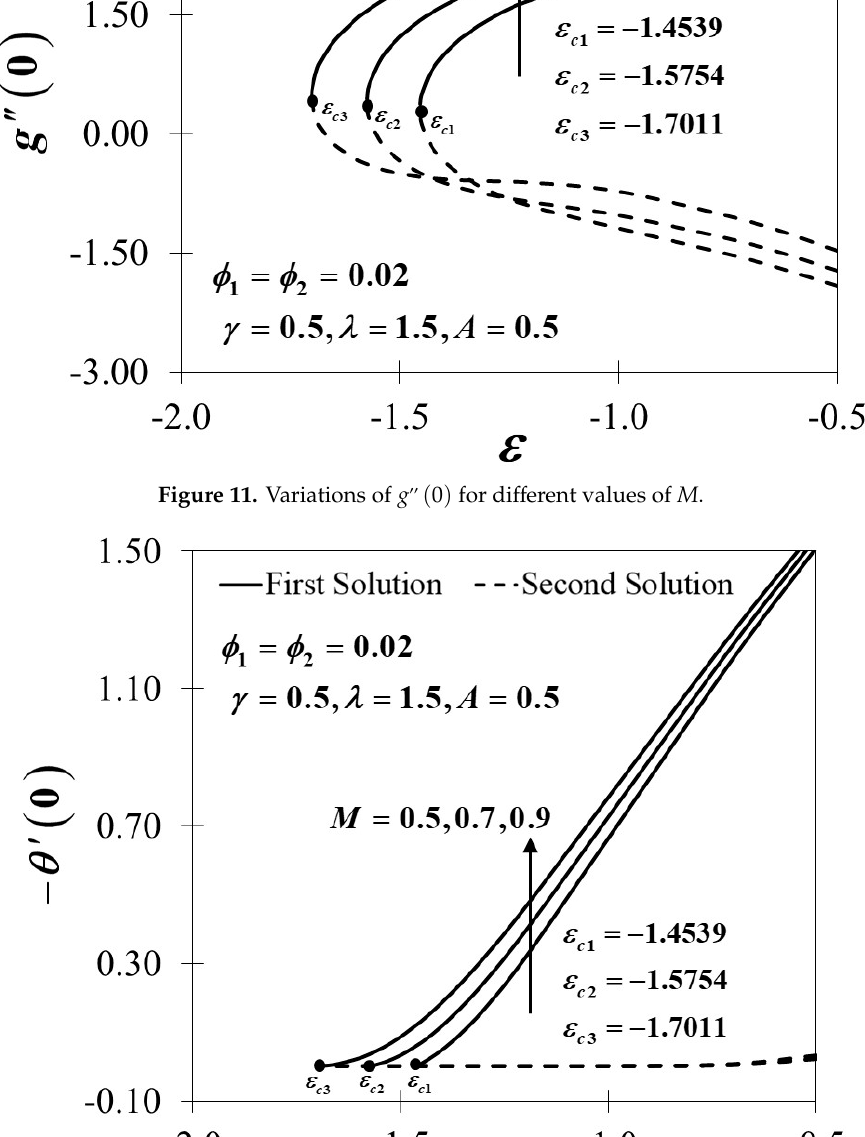
Figure 12. Variations of − θ (cid:48) ( 0 ) for di ff erent values of M .